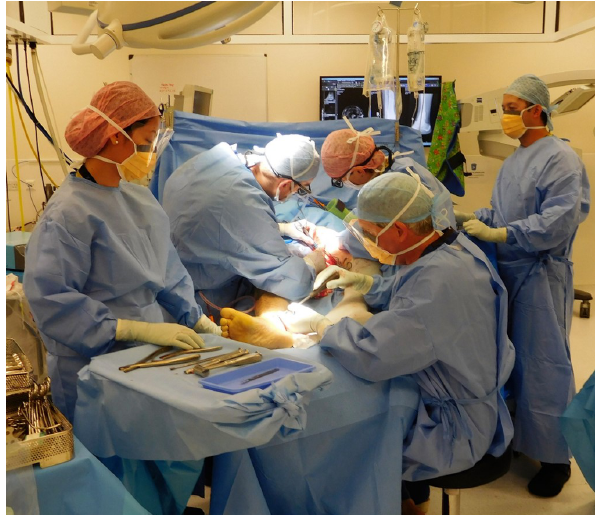
Figure 5. Two teams work together to harvest a gracilis muscle flap from the left thigh and excise an infected non-union from the right